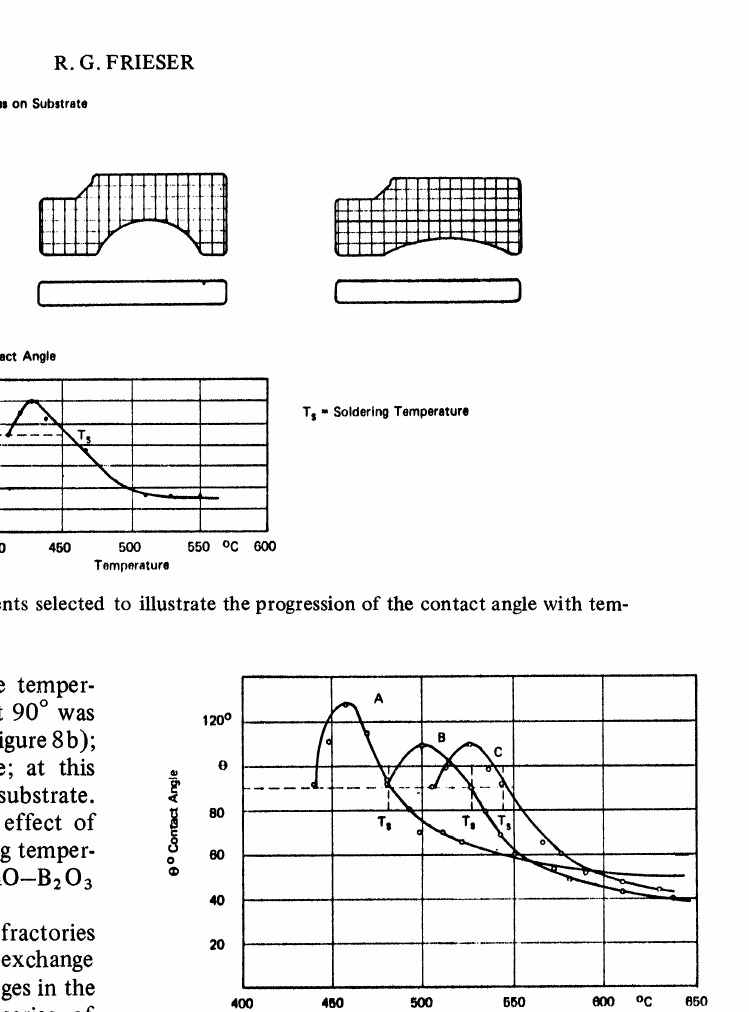
FIGURE 9 Contact angle vs. temperature curves of Zn-Pb borate glass?